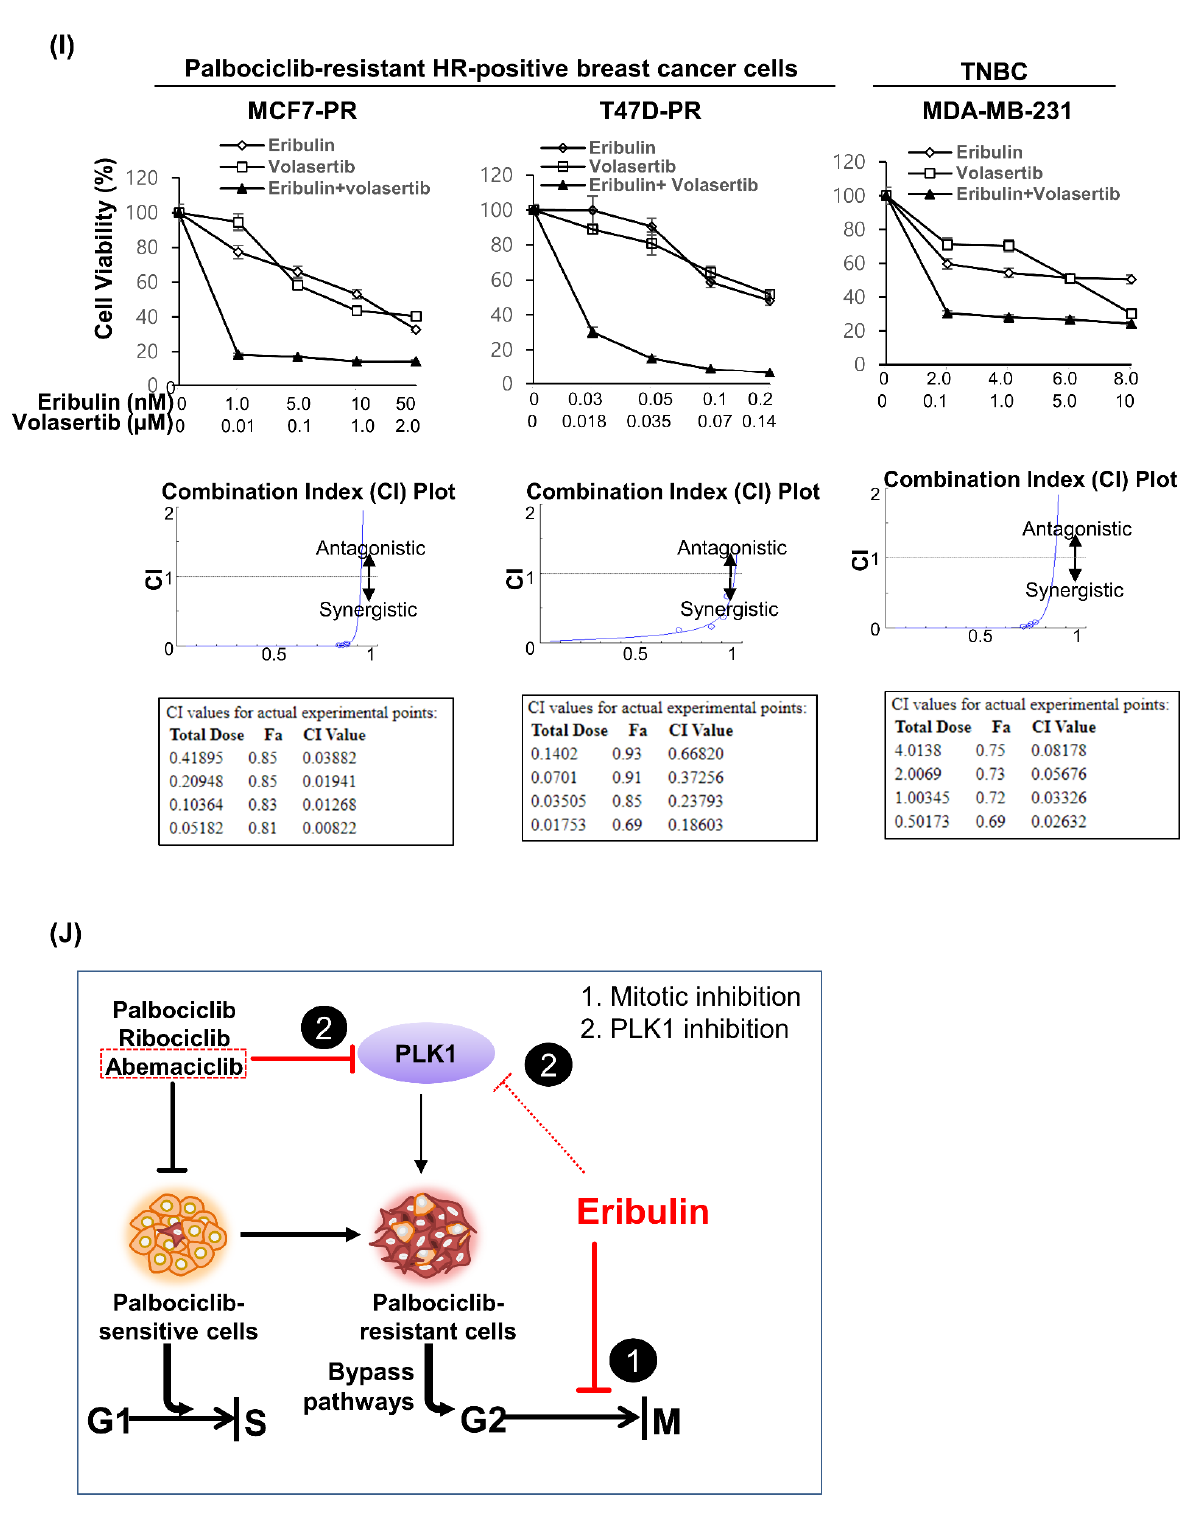
Figure 4. Eribulin synergizes abemaciclib via PLK1 inhibition in the G2/M phase. ( A ) PLK1 ex- pression in palbociclib-resistant cells compared with their sensitive counterparts was analyzed by western blot. ( B ) Correlation of CCLE, PLK1 gene and palbociclib sensitivity, which was defined as IC50 ≤ 500 nM in breast cancer cell lines. p -value was calculated by Student’s t -tests. ( C ) MCF7-PR cells were treated with IC50 concentration of palbociclib or abemaciclib for 48 h. PLK1 expression was analyzed by western blot. ( D ) Relative mRNA expression determined by qRT-PCR. PLK1 in